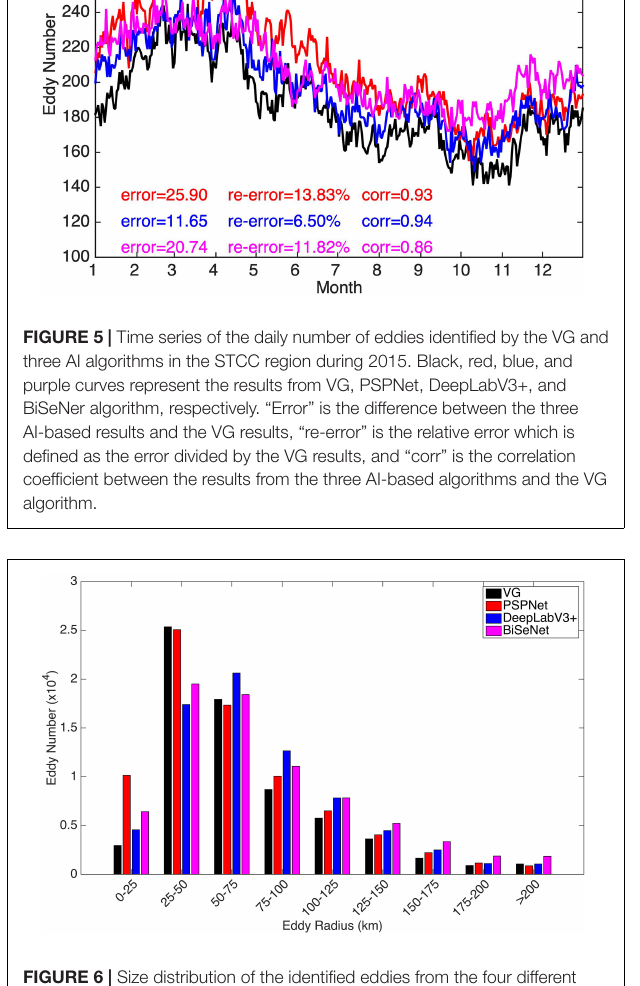
FIGURE 7 | Same as Figure 5 except for the comparison of the daily number of eddies with radii greater than 25 km.